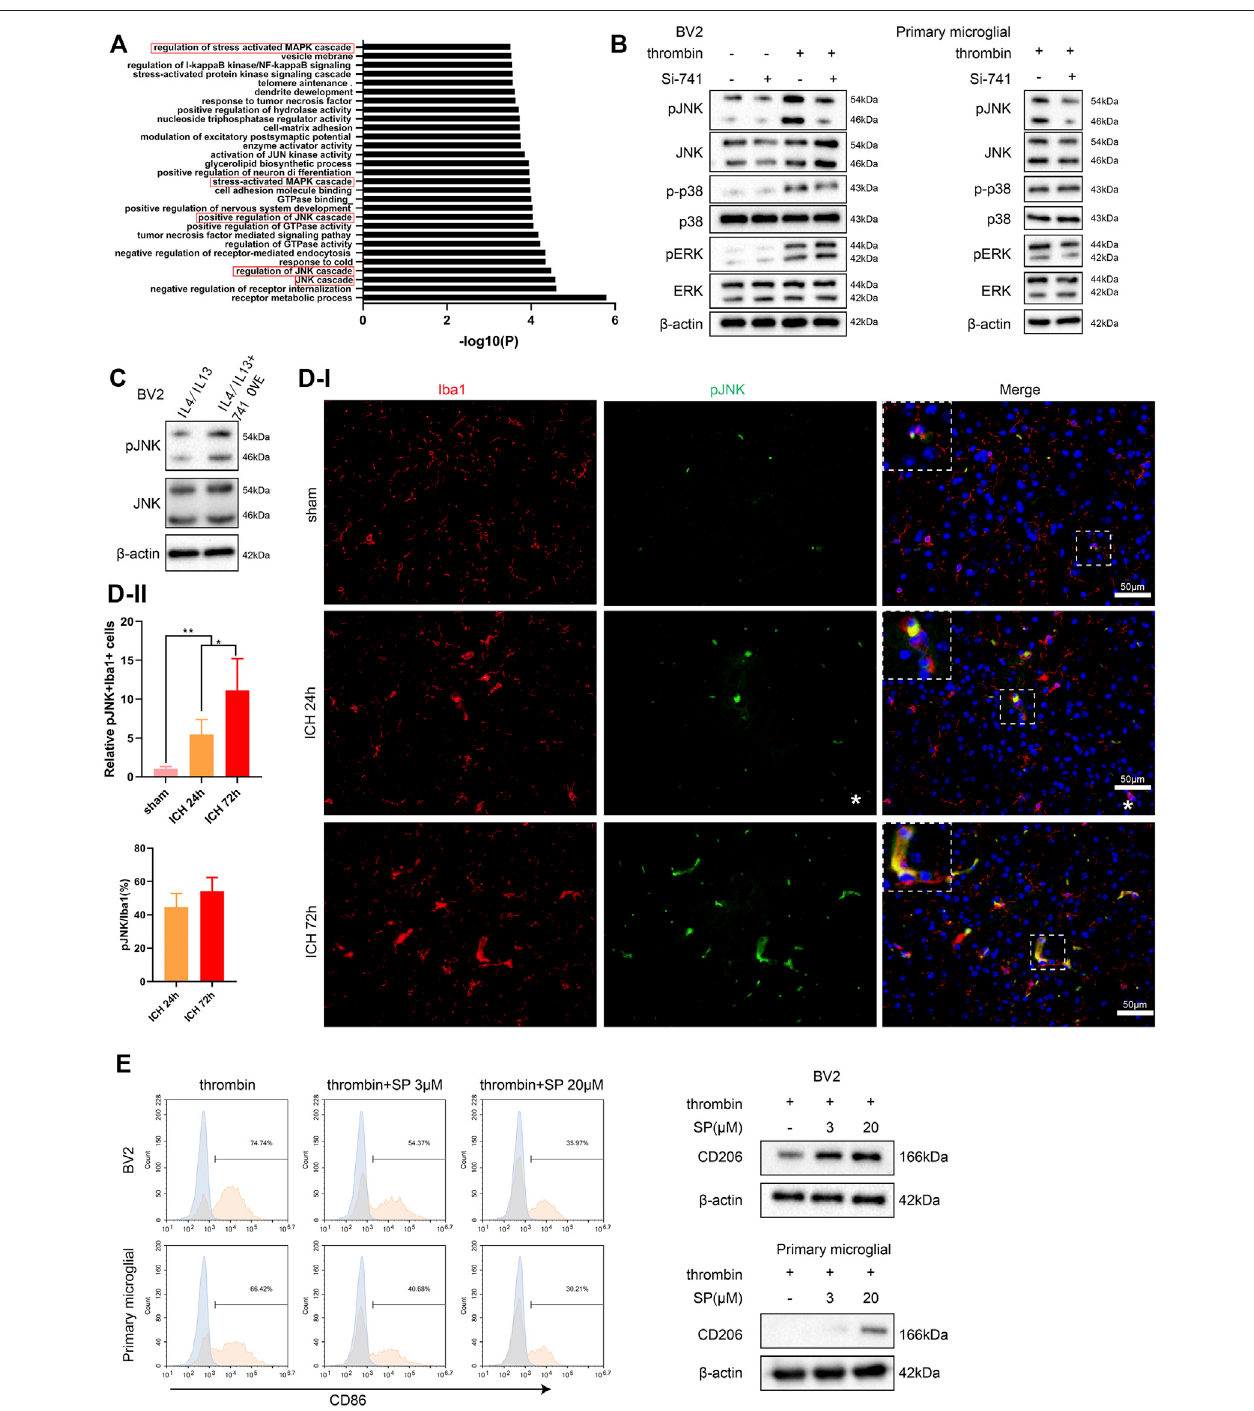
FIGURE4| In fl uenceofTCONS_00145741ontheactivationoftheJNKpathwayinmicrogliaunderthrombintreatment. (A) GeneOntology(GO)analysisofmRNA relatedtoTCONS_00145741inthesequencing results. (B) si-741wastransfectedintoBV2cellsandprimary microgliaand thentreatedthecellswith20U/mlthrombin for24 h.Detectionofp-JNK,JNK,p-p38,p38,pERK,andERKproteinlevelsbyWesternblot. (C) 741OVEwastransfectedintoBV2cellsandthentreatedthecellswith 10 ng/ml IL-4 and 10 ng/ml IL-13 for 24 h. Detection of p-JNK and JNK protein levels using Western blot. (D) Iba1/p-JNK double staining of the area around hematoma in vivo (Scale bar (cid:2) 50 μ m). (E) After treating BV2 cells and primary microglia with thrombin, the cells were treated with 3 μ M or 20 μ M JNK pathway inhibitor SP600125. Detection of CD86 by fl ow cytometry and analysis of CD206 protein level by Western blot. ** p < 0.01 vs. sham. * p < 0.05 vs. ICH 24 h. Si-741: si- TCONS_00145741, 741 OVE: the overexpression of TCONS_00145741, SP: SP600125.